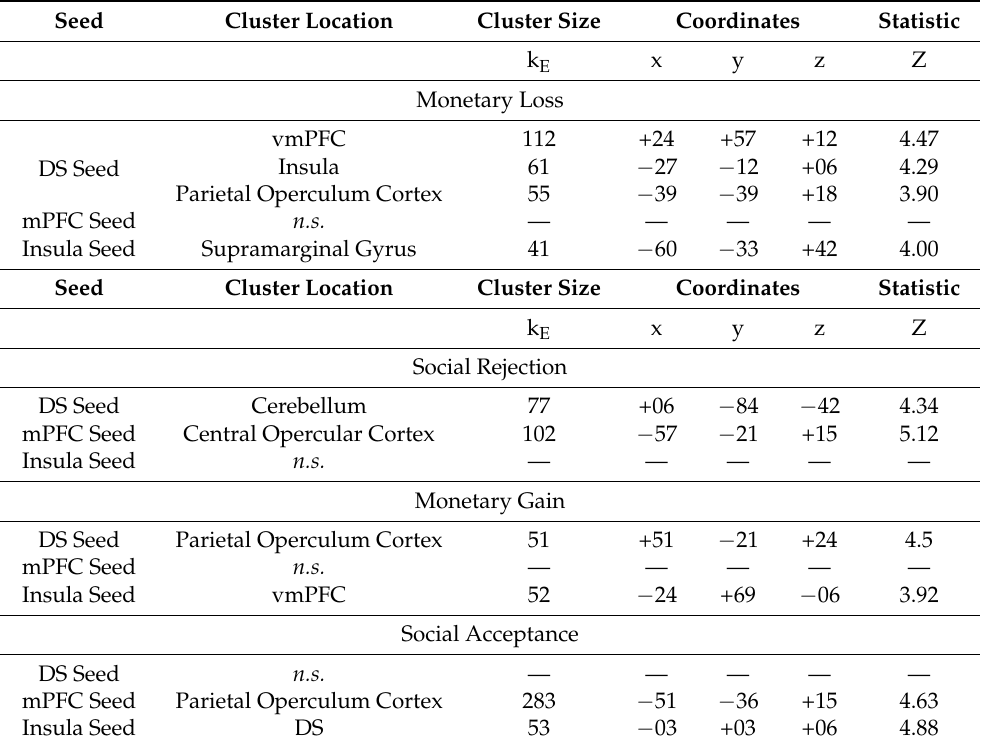
Table 3. Whole-brain connectivity results: Differences between youth with and without NSSI. Seed